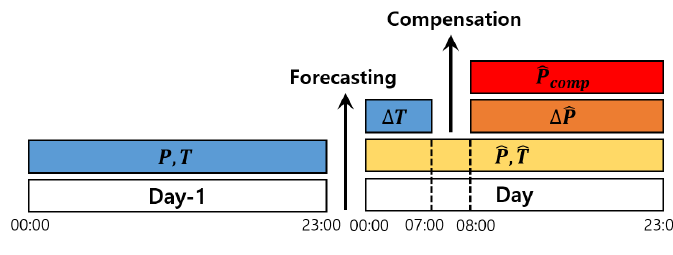
Figure 5. Timeline of the forecast compensation procedure.